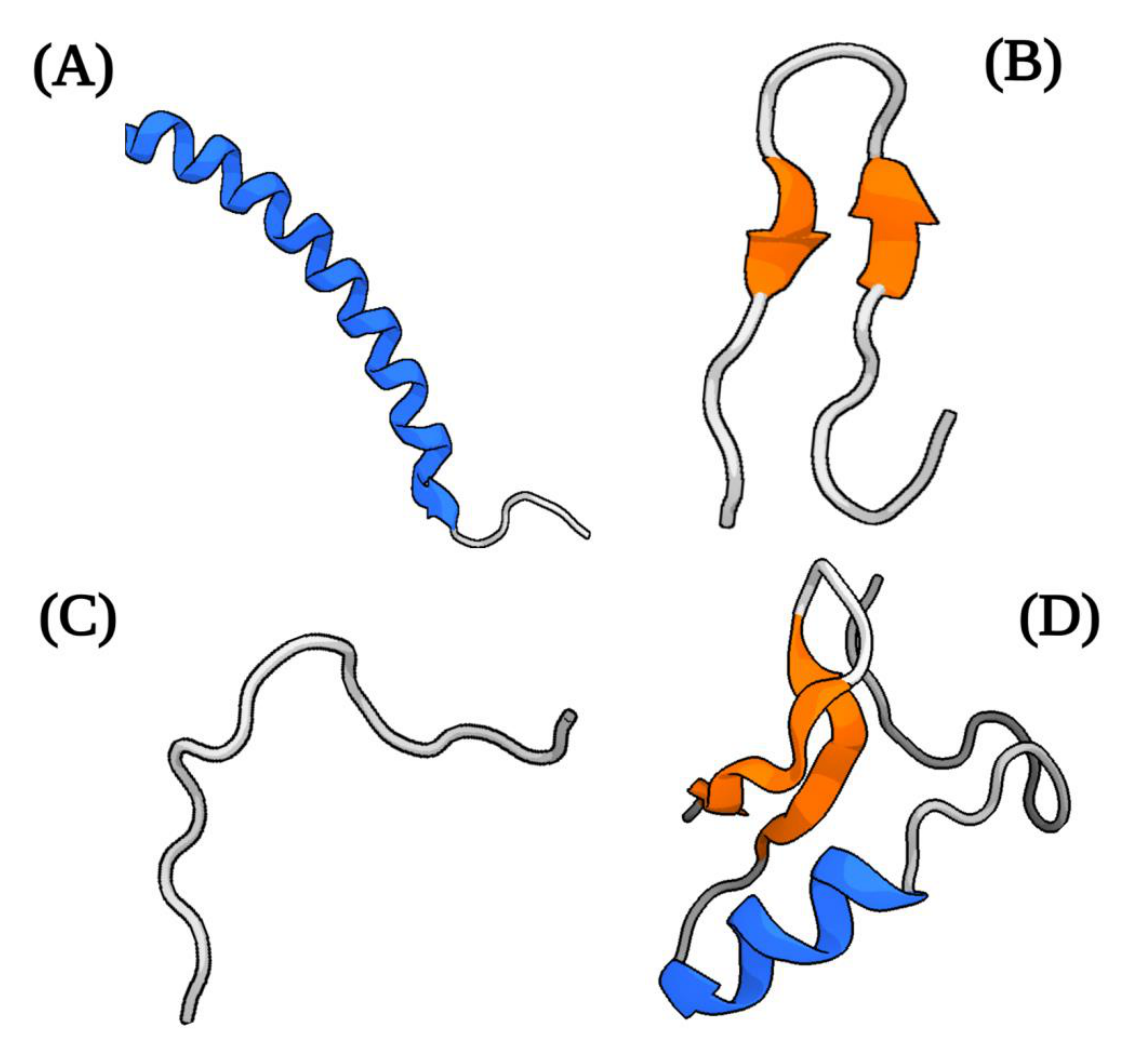
Figure 1. Structural classification common of naturally antimicrobial peptides (AMPs). Representa- tive examples of common structural classes of AMPs. ( A ). α-Helical: structure of human cathelicidin LL-37 (PDB ID:2k60). ( B ). β-Sheet: polyphemusin I (PDB ID:1RKK). ( C ). Extended or loop: indolici- din (PDB ID:1G89). ( D ). Mixed (contain both α-helical and β-sheet elements): Defensin A (PDB ID: